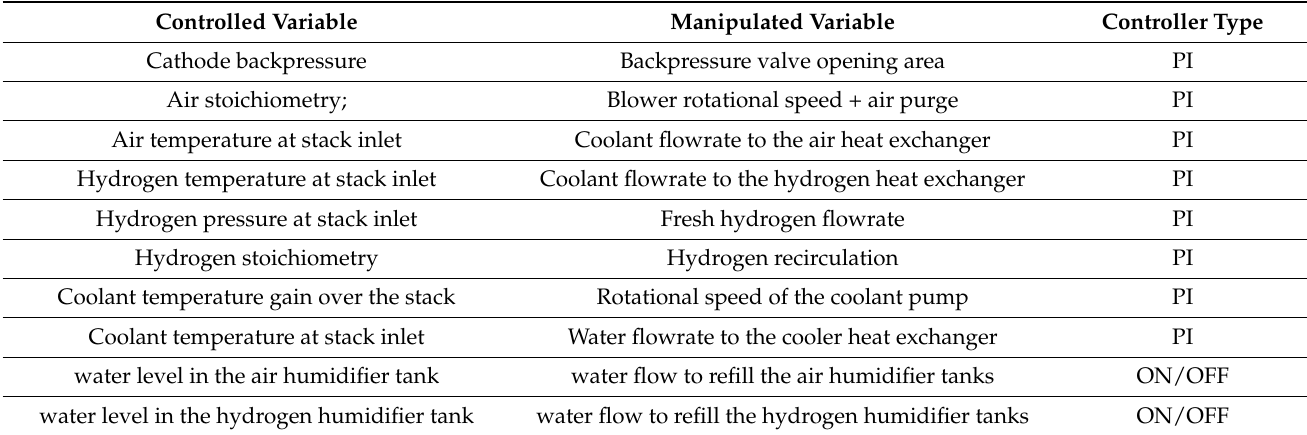
Table 2 details the controller implemented in the model. Table 2. Control system: controlled variables, manipulated variables, and controller